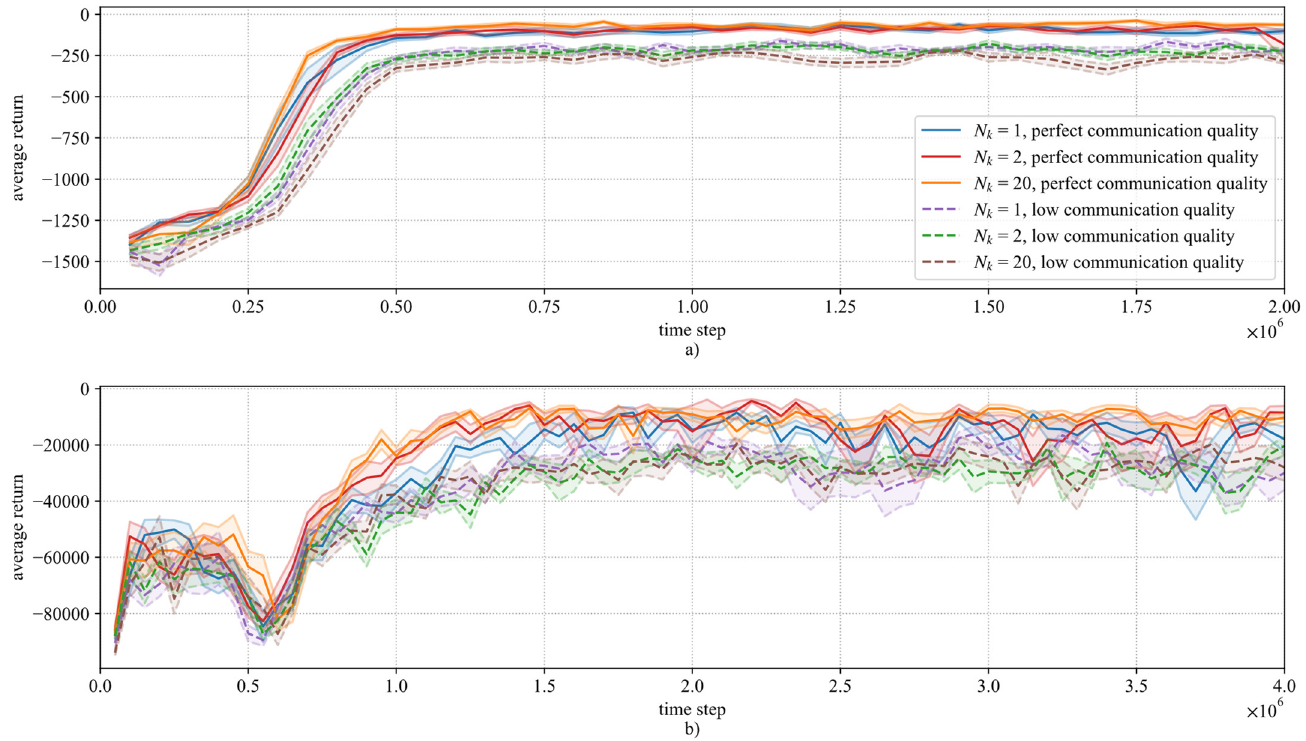
Figure 4. Average return and standard error for multiple runs of the EM-RL ( a ) and PM-RL ( b ) reward function para-